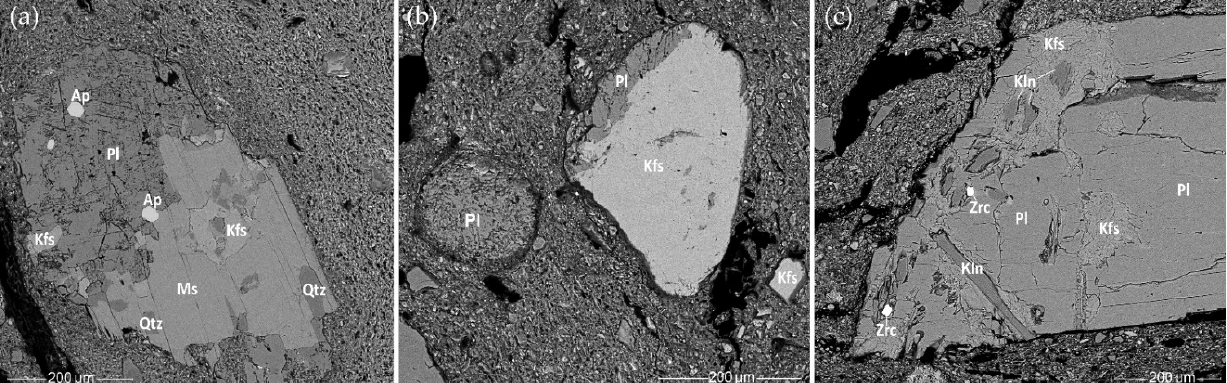
Figure 13. SEM BSE images of plagioclase in the samples: ( a ) HG-L_B4, different weathering stages of minerals seen in the rock fragment—muscovite, quartz, K-feldspar have clear boundaries but plagioclase turns to clay; ( b ) CW-E_M3, a round grain of weathered plagioclase turns into clay; ( c ) CW-E_M1, weathered plagioclase with areas of kaolinite.